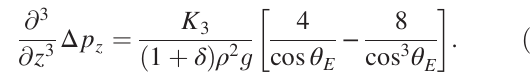
for the dipole exit. co